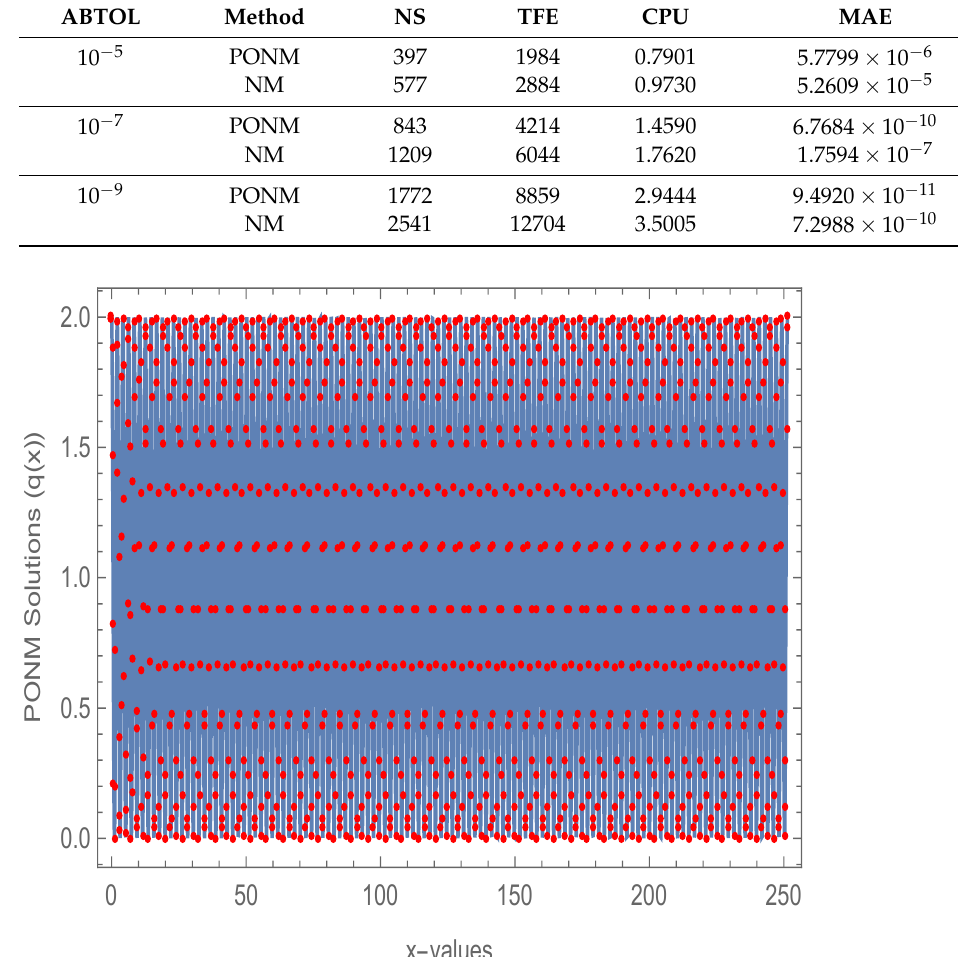
Figure 2. Comparison of PONM and the exact solution for